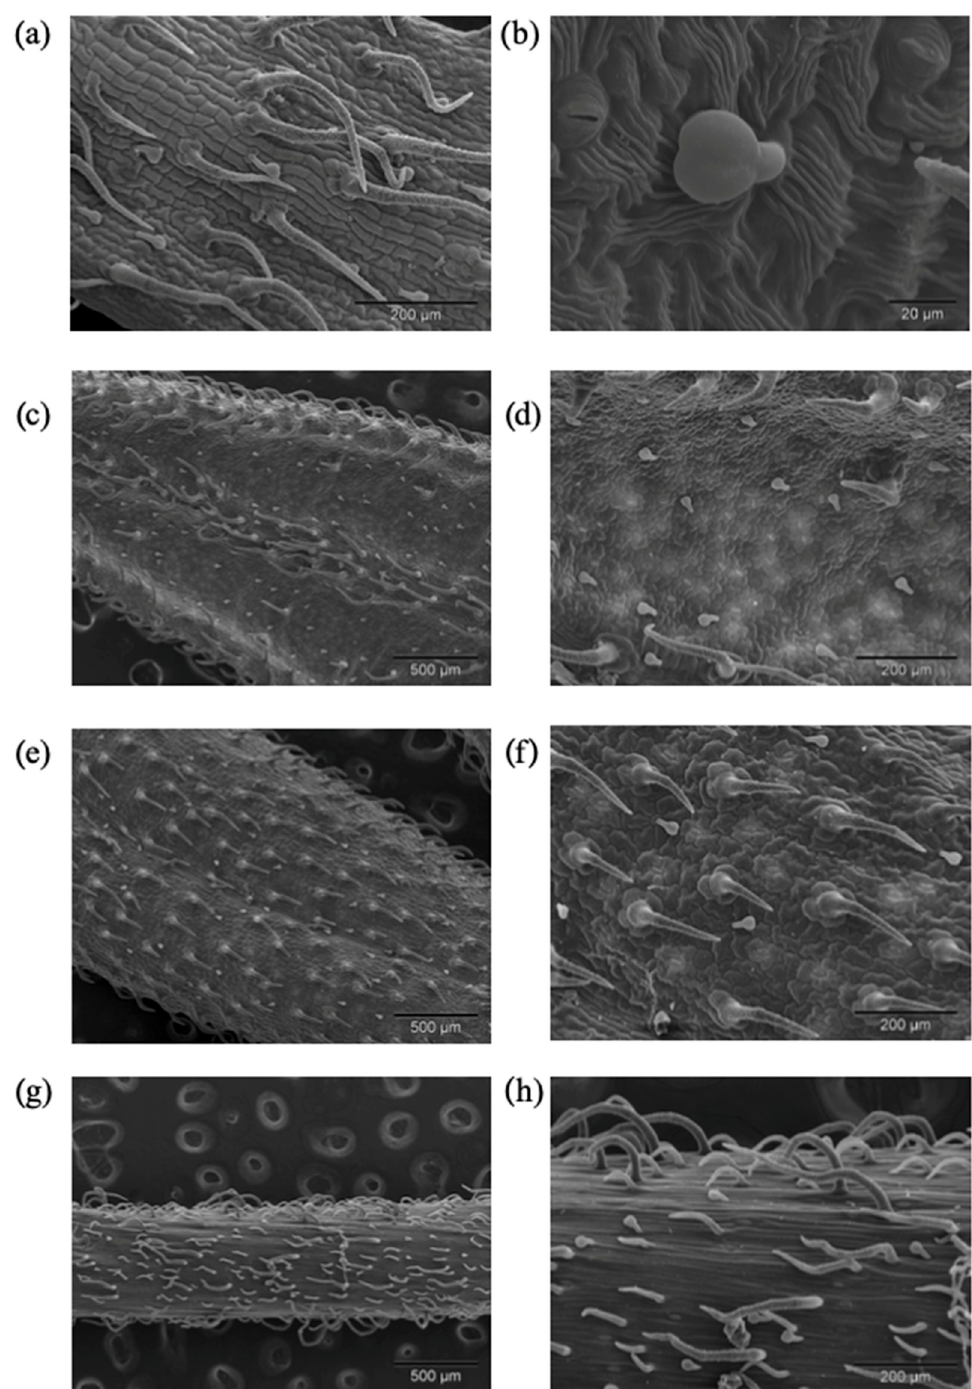
Figure 4. V. austriaca ssp. jacquinii SEM micrographs showing differences in the distribution of the trichomes on sepal ( a , b ), abaxial ( c , d ) and adaxial ( e , f ) leaf surface, and stem ( g , h